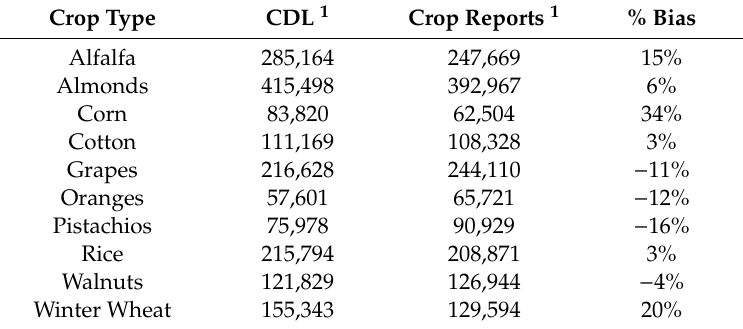
Table 1. Comparison of the area counts between the USDA-NASS Generalized Cropland Data Layer (CDL) and the aggregated county crop acreage reports from 2008 to 2017 for the top 10 crops in the Central Valley showing: (1) the average crop area in hectares from pixel-counting the generalized CDL, (2) the average crop area from the aggregated crop reports, and (3) the bias percentage that was used to bias-correct the CDL area to calculate water use between 2008 and 2018. Crop Type CDL 1 Crop Reports 1 % Bias Alfalfa 285,164